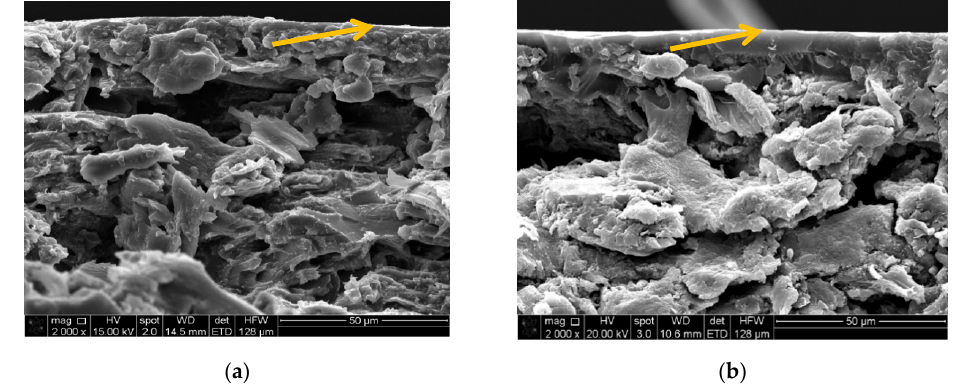
Figure 9. SEM micrographs of exposed overlaid samples (melamine layer on the top): ( a ) exposed MDF; ( b ) exposed PB; (yellow arrows indicate the borderline between the overlay and substrate).